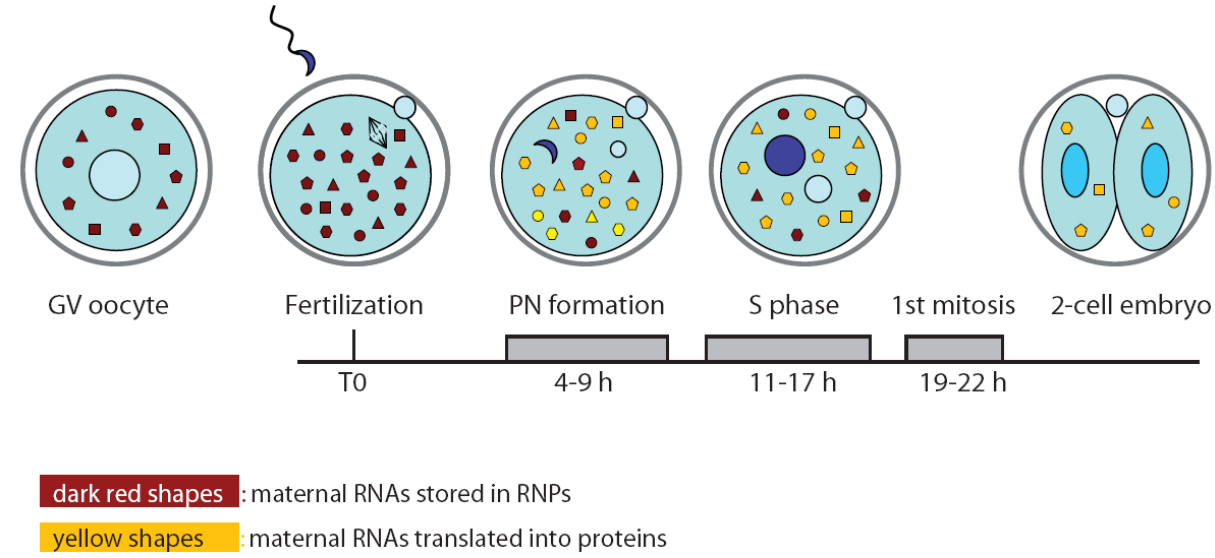
Figure 2. Maternal mRNAs are accumulated during oogenesis and bound by proteins in complexes called RNPs (ribonucleoproteins). Maternal mRNAs are stored in an inactive masked state until recruited for translation in a stage-specific manner. Soon after fertilization maternal RNAs are loaded onto polysomes for translation, in order to provide essential factors to the newly formed zygote, before the full activation of its genome occurs. At the two-cell stage 90% of the maternal transcripts will be degraded. The starting point for timing (hours) is